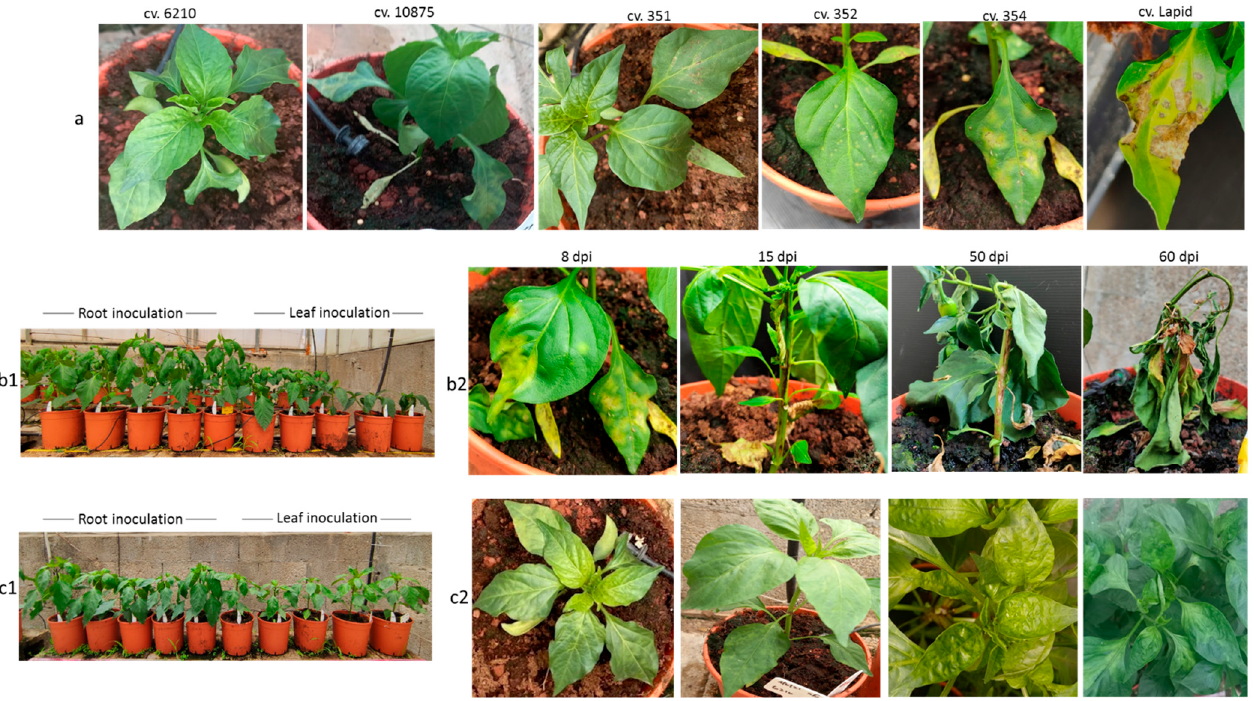
(Figure 1a). Yellowing and shedding of the inoculated leaves followed the HR response.